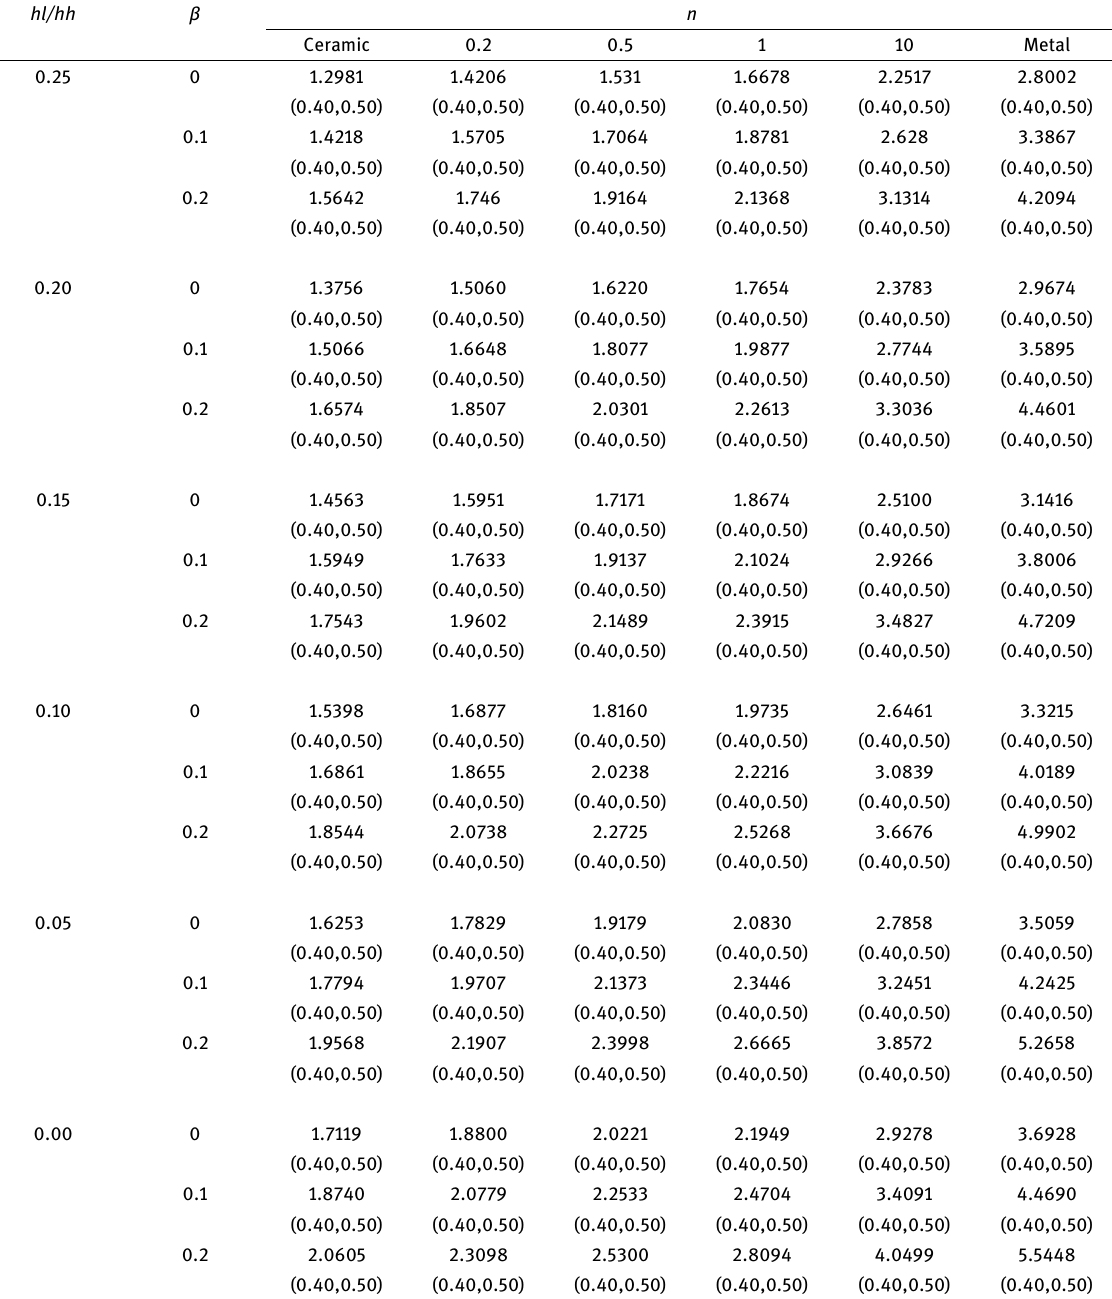
Table 7: Variation of non-dimensional deflection of simply supported FGM porous conoidal shell subjected to uniform loading ( a / h = 10 ).